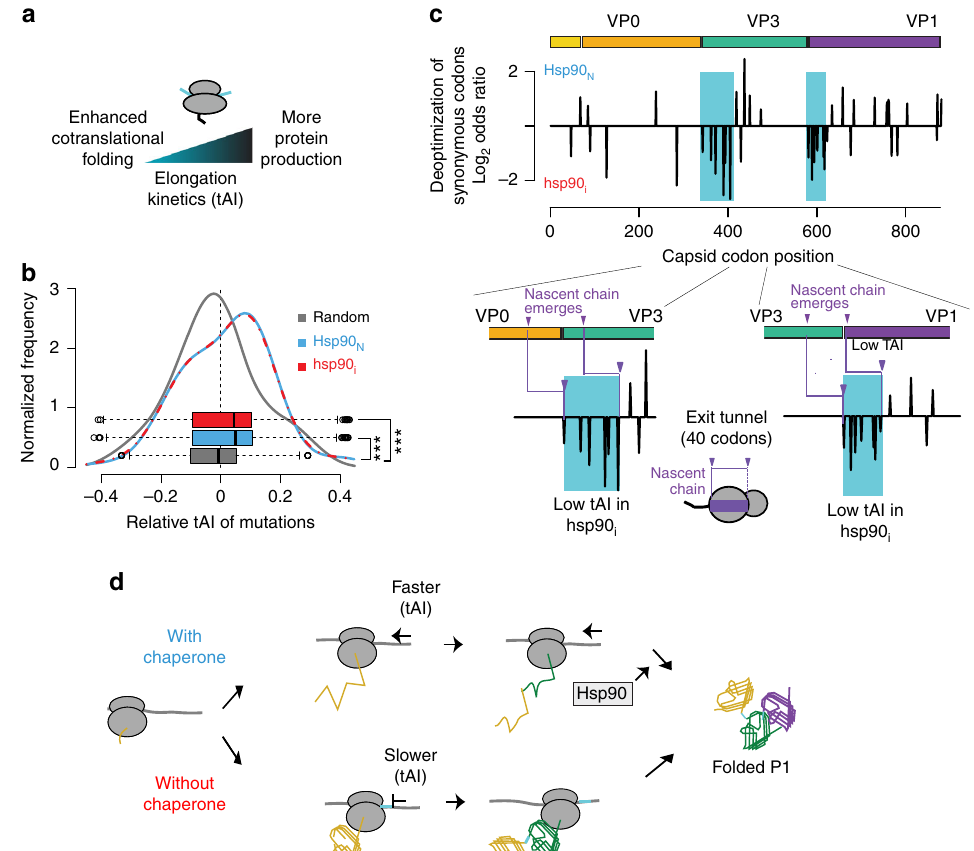
Fig. 5 Localized codon de-optimization upon adaptation to Hsp90 inhibition. a Interplay between the rate of translation, cotranslational folding, and protein production. b Both Hsp90 N and hsp90 i poliovirus populations accumulate synonymous variants resulting in global codon optimization. The change in codon optimality was calculated for all synonymous mutations observed in hsp90 i and Hsp90 N populations as well as for a random sample of mutations (random) based on the HeLa cell tRNA adaptation index (tAI). c Distribution of sites harboring signi fi cantly deoptimized synonymous codons across P1 in hsp90 i and Hsp90 N populations. The domain structure of P1 is indicated. Insets show the two clusters of deoptimized codons in hsp90 i (indicated with blue shading) relative to domain boundaries of VP0/VP3 (left) and VP3/VP1 (right). The approximate size of the ribosomal exit tunnel and the point at which the nascent-chain (n. chain) emerged from the ribosome are indicated in purple. d Model of the potential impact of chaperone levels on codon de-optimization at domain boundaries. Under conditions of Hsp90 inhibition, the virus locally reduces translation speeds to promote cotranslational folding. While enhancing correct cotranslational P1 folding, this strategy may slow protein production. For boxplots, the center line represents the median, the bound box the interquartile range, and the whiskers 1.5× the interquartile range. Signi fi cance: *** p < 0.005 by Mann – Whitney – Wilcoxon